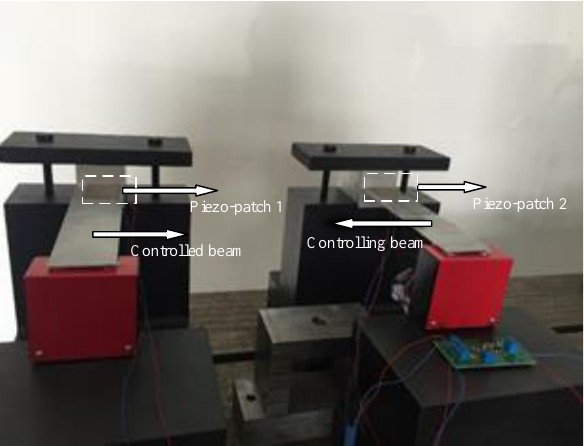
Figure 17. Double-beam system.